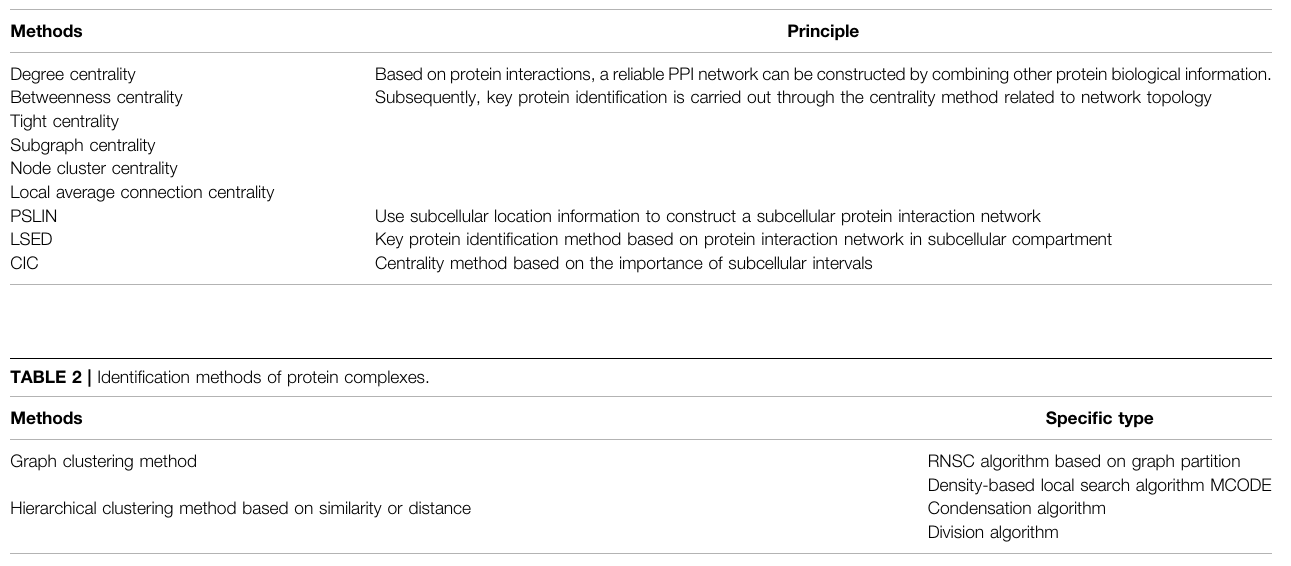
Hierarchical clustering method based on similarity or distance Condensation algorithm